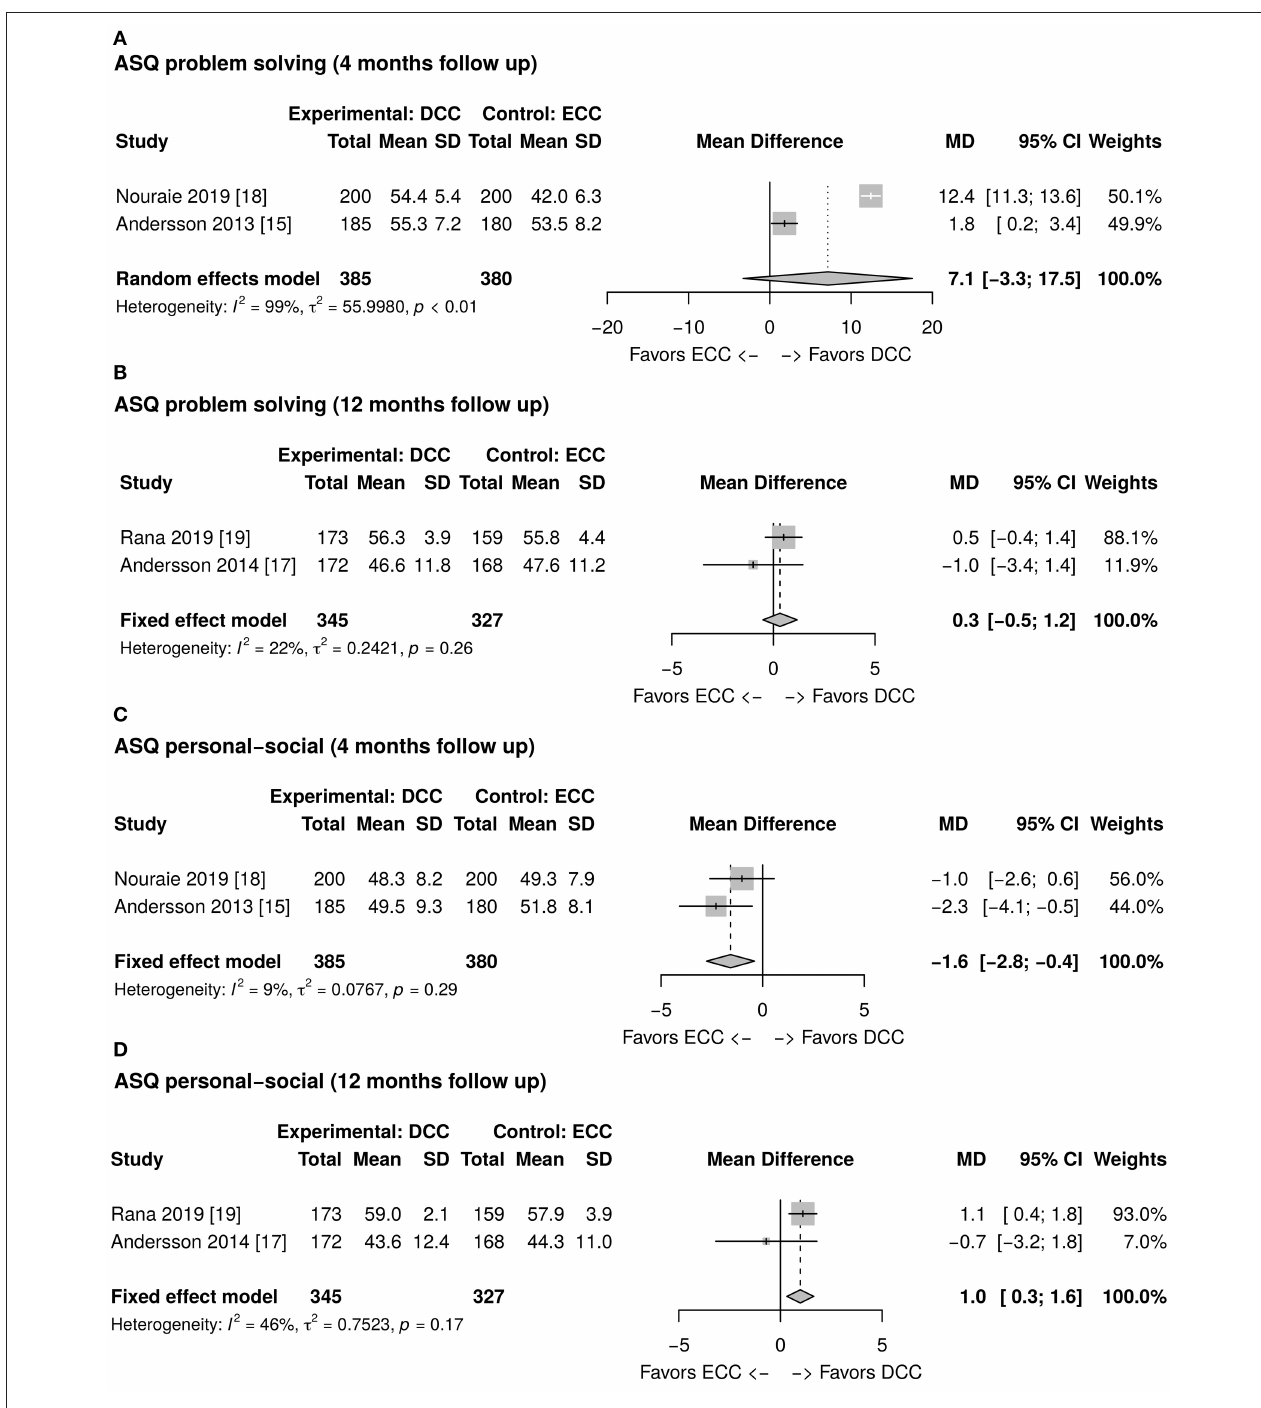
FIGURE 4 | (A) Forest plot showing mean difference of the Ages and Stages Questionnaire (ASQ) problem solving domain score at 4 months follow up between delayed cord clamping (DCC) and early cord clamping (ECC) groups. (B) Forest plot showing mean difference of the ASQ problem solving domain score at 12 months follow up between DCC and ECC groups. (C) Forest plot showing mean difference of the ASQ personal-social domain score at 4 months follow up between DCC and ECC groups. (D) Forest plot showing mean difference of the ASQ personal-social domain score at 12 months follow up between DCC and ECC groups.